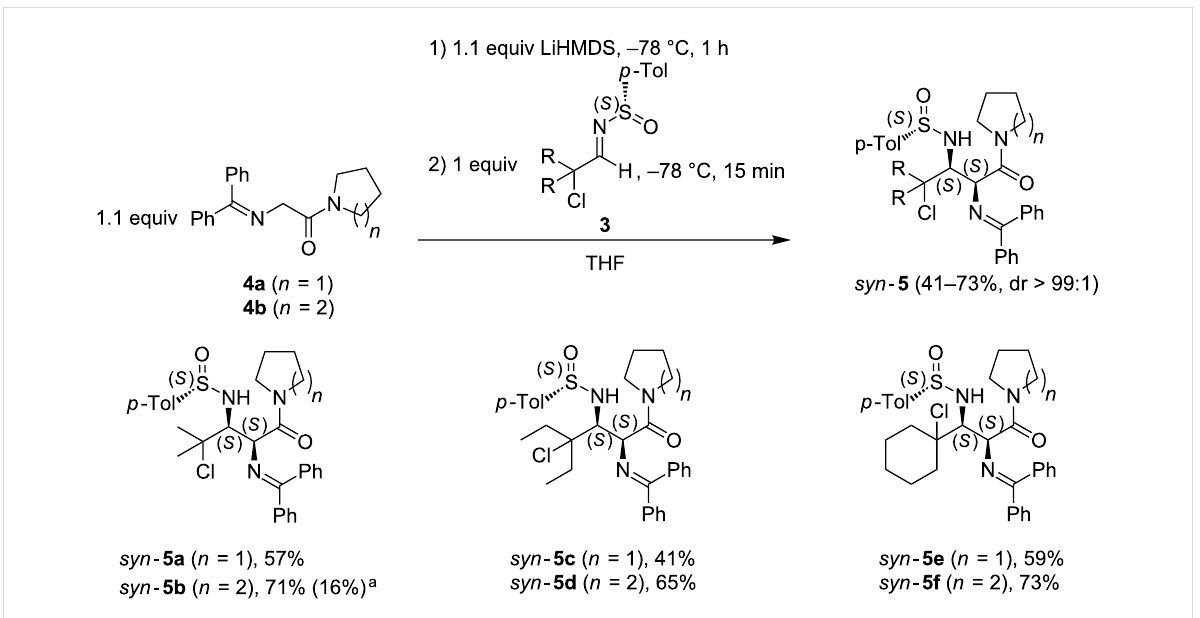
Scheme 2: Synthesis of ( S S ,2 S ,3 S )- γ -chloro- α , β -diaminocarboxylamides 5 . a Yield in parentheses results from the use of LDA instead of LiHMDS.